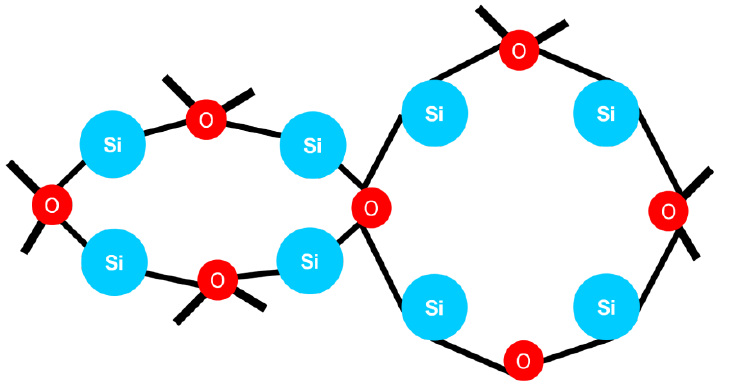
Figure 5. Diagram of the four-fold siloxane rings in sol – gel silica.